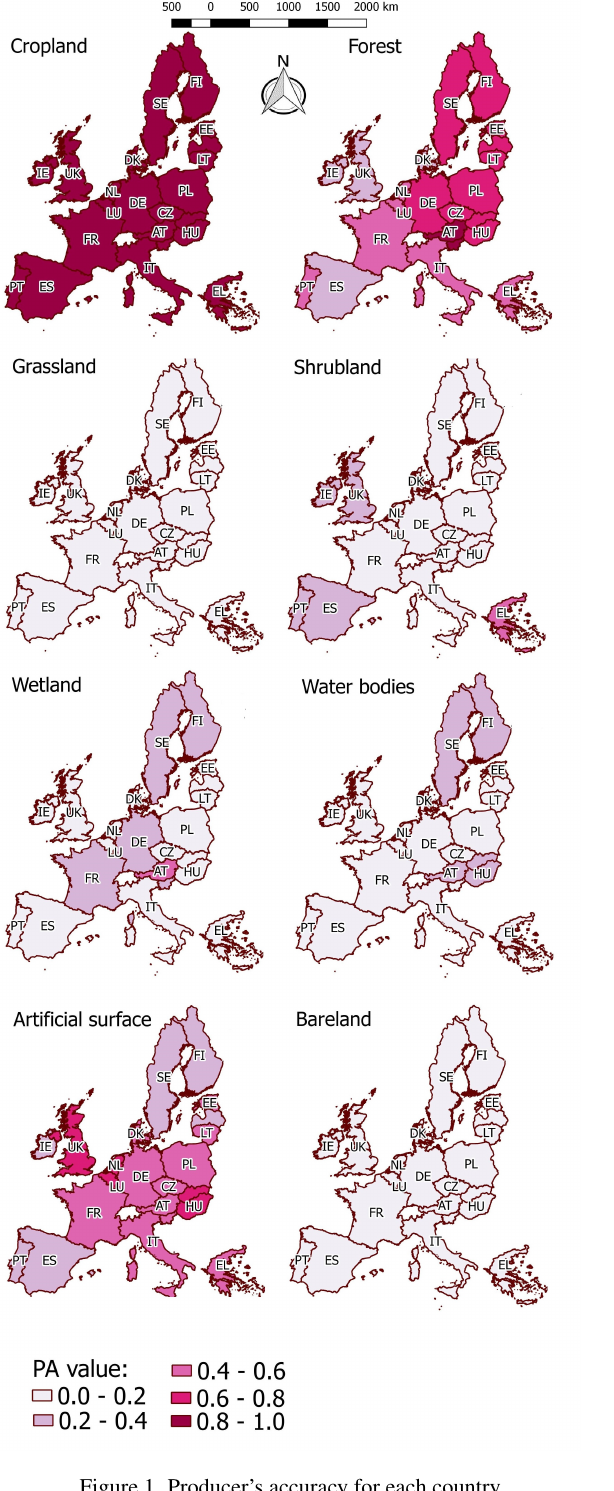
that all of the indexes computed based on DUSAF, except indexes of disagreement, exceed the ones computed based on LUCAS. On the opposite side, the disagreement indexes have switched places in the terms of higher one, because in the case of DUSAF, AD surpasses QD. As the DUSAF dataset is known to be an ac- curate one, values of the indexes raise doubts that LUCAS might be suitable for the assessment of